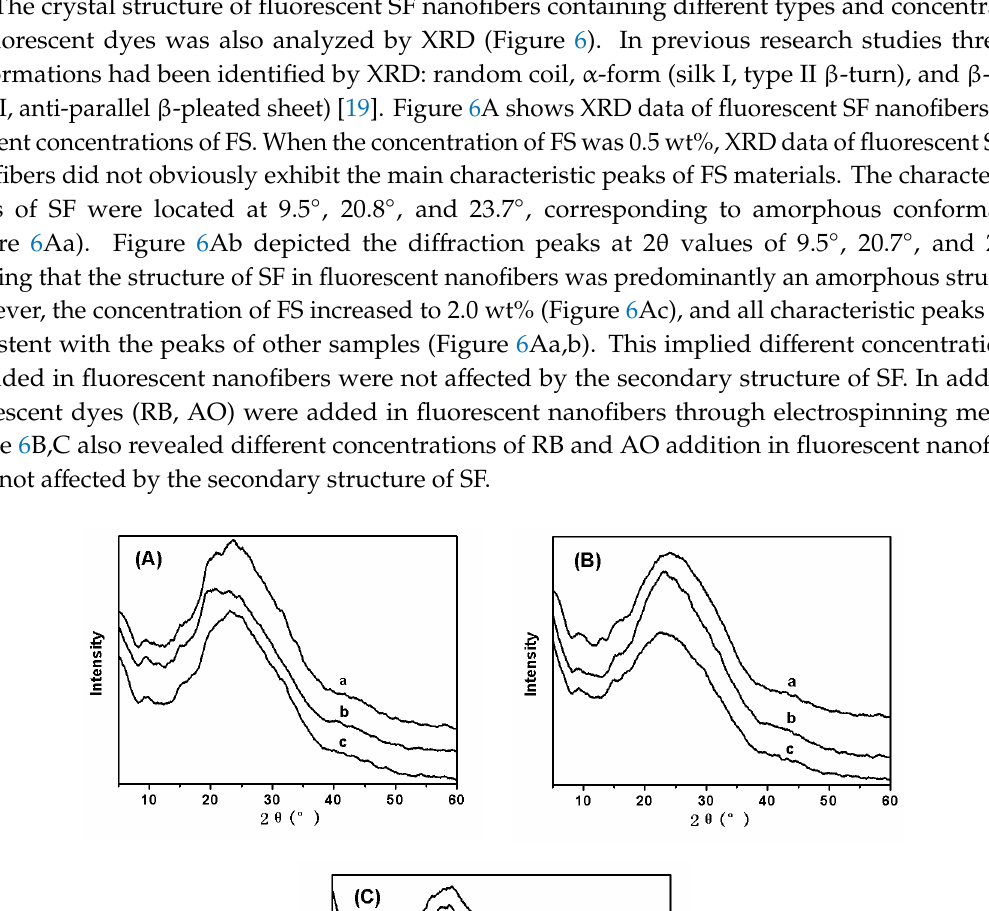
Figure 5. FTIR spectra of fluorescent SF nanofibers with different concentration of fluorescent sodium: ( a ) 0 wt%, ( b ) 0.5 wt%, ( c ) 1.0 wt%, and ( d ) 2.0 wt%, respectively. At the same time, the concentration of SF in electrospinning solution was 10.0 wt%.